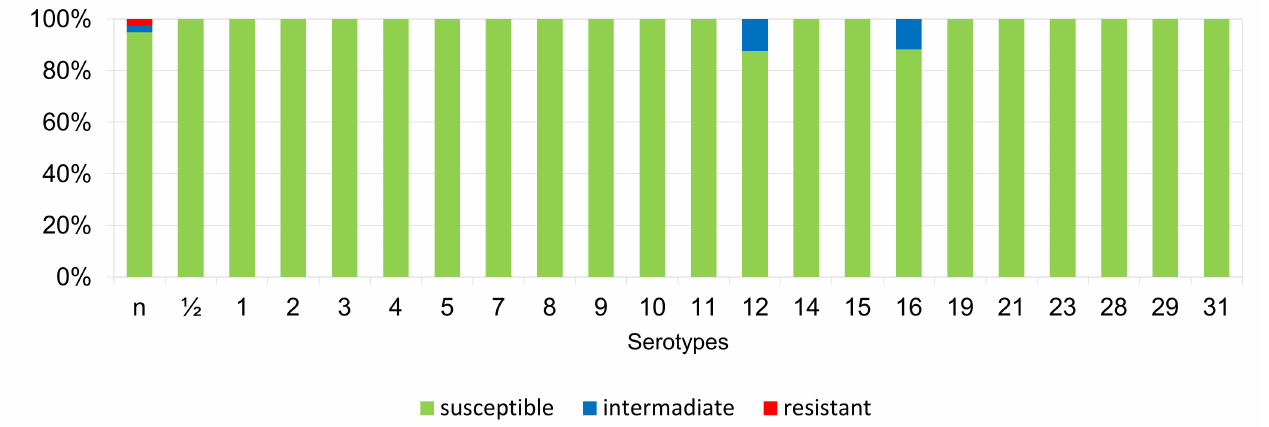
Figure 6. Percentage representation of isolates that are resistant, intermediately resistant, and suscep- tible to penicillin belonging to individual S. suis serotypes from the Czech Republic during 2018–2022 ( n = 506). n = non-typeable isolates.